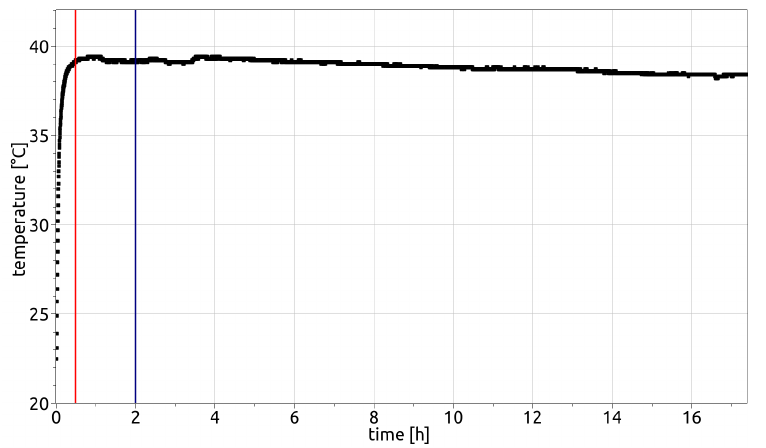
Figure 12. The heat-up curve of AFE no. 10 measured inside the housing using a thermocouple and Keithley 6517A electrometer.